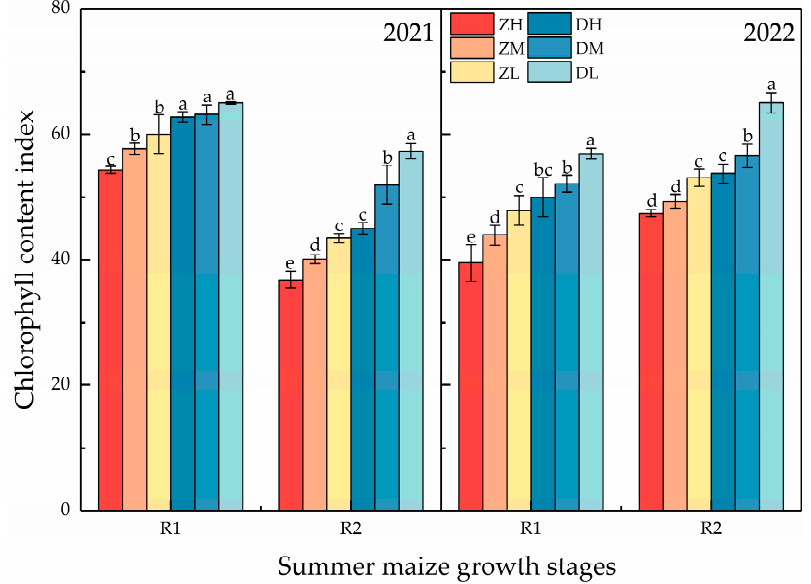
Figure 4. Effects of planting densities and genotypes on CCI at R1 (silking stage) and R2 (filling stage) in 2021 and 2022 summer maize growing seasons. Z represents Zhengdan 958, D represents Denghai 605; H represents high density, M represents middle density, and L represents low density. Vertical bars represent standard errors. Bars labeled at the top of the column with different letters are significantly ( p < 0.05) different among treatments using LSD post hoc test.